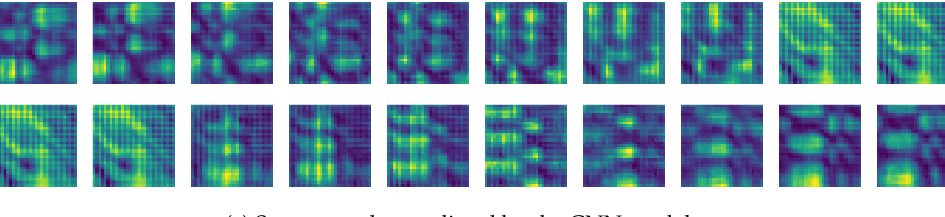
( c ) Some samples predicted by the CNN model. Figure 21. Some samples for running motion: ( a ) predicted results of the FNO model, ( b ) target cross recurrence plot, and ( c ) predicted results of the CNN